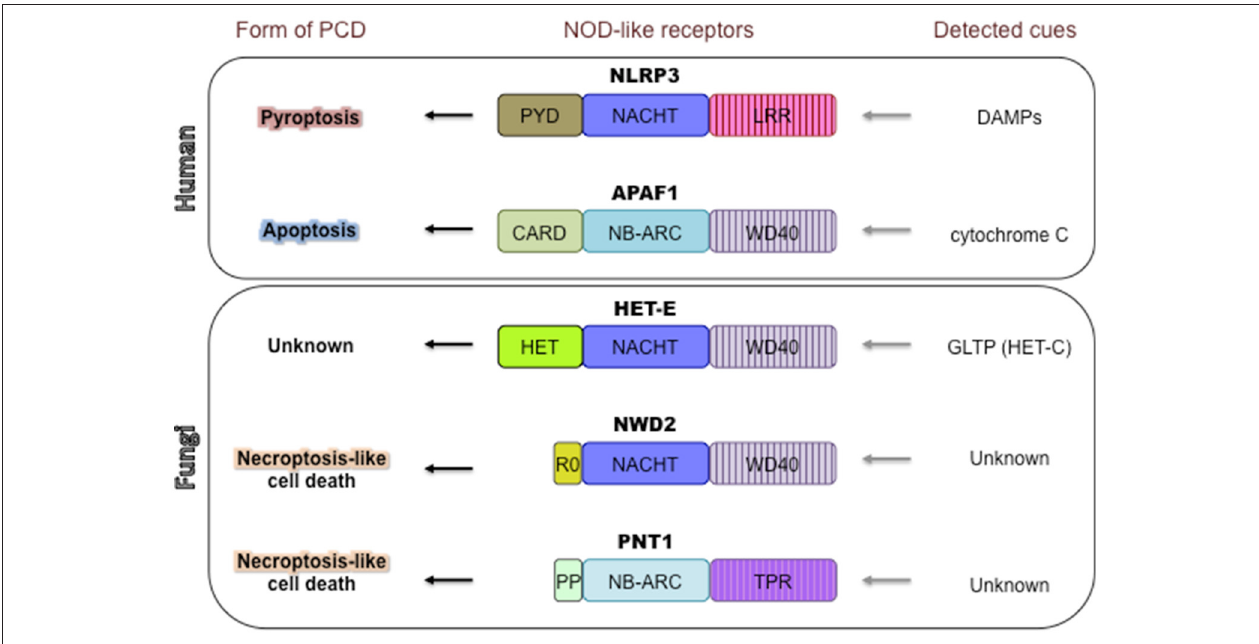
FIGURE 3 | NOD-like receptors control various forms of PCD in mammals and filamentous fungi. NLRP3 and APAF1, given as examples, control pyroptosis and apoptosis, respectively. NLRP3 activity is triggered by various DAMPs (damage-associated molecular patterns), which leads to highly inflammatory pyroptotic cell death (Jones et al., 2016). APAF1 controls the intrinsic apoptotic cell death pathway in mammals (Shakeri et al., 2017). APAF1 is activated by cytochrome C, released from damaged mitochondria. Three examples are given of fungal NOD-like receptors controlling PCD. HET-E controls the HI PCD reaction in the ascomycete P. anserina. PCD is triggered by incompatible allelic variants of HET-C, a glycolipid transfer protein (GLTP). The downstream signaling pathway of HET-E activation and specific mechanism of cell death are currently unclear. Some fungal NLRs (e.g., NWD2 of P. anserina or PNT1 of Chaetomium globosum ) use short amyloid motifs (R0 or PP (pseudo-palindromic) respectively) to induce a cell death reaction that has been linked to necroptosis —inflammatory PCD in metazoans (Loquet and Saupe, 2017). The molecular cues and events activating NWD2 and PNT1 are not yet identified.